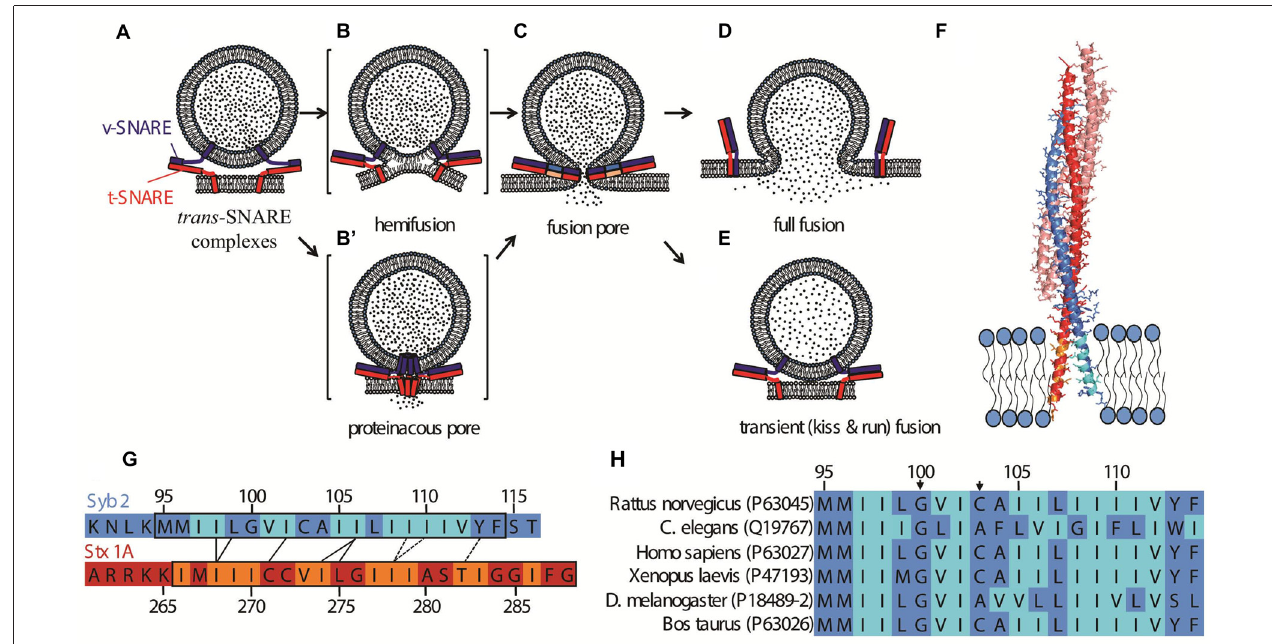
FIGURE 1 | Possible fusion pathways for soluble N-ethyl maleimide sensitive factor attachment protein receptors (SNARE)-mediated fusion, and the structure of the post-fusion cis SNARE complex (Stein et al., 2009). (A) A synaptic vesicle is docked at the plasma membrane by trans -SNARE complexes. The exocytotic/neuronal v-SNARE Syb2 (blue) and the t-SNARE (Stx1 and SNAP25, depicted together in red) are anchored to the synaptic vesicle and the plasma membrane, respectively via their transmembrane domains (TMDs). Further zippering, coupled with the action of the calcium sensor Synaptotagmin-1 (not shown) and possibly other factors leads to the opening of a fusion pore (C) . Possible intermediate structures on the pathway to opening of the fusion pore include a hemifusion state (B) wherein the proximal leaflets, but not the distal ones, are fused. An alternative intermediate is a channel-like structure formed by oligomerization of the TMDs of soluble N-ethyl maleimide sensitive factor attachment protein receptors (SNAREs) in both membranes (B (cid:48) ) . Hetero-oligomerization of SNAREs with other proteins may also contribute to the channel structure. Expansion of the proteinaceous pore would lead to invasion of the pore’s walls by lipids. In (C) , the SNAREs are shown fully zippered at the waist of the pore, but the actual structure is unknown. The fusion pore can fluctuate in size, and flicker open and shut multiple times before expanding further, leading to full fusion (D) , or resealing, concluding a transient or kiss-and-run fusion event (E). (F) Structure of the cis -SNARE complex (adapted from Stein et al., 2009), PDB file 3HD7, rendered in PyMol). The t-SNAREs Syntaxin 1A and SNAP25 are shown in red and salmon, respectively; the v-SNARE Syb2 is shown in blue; TMDs are shown inserted into a membrane. Beta-branched residues are indicated in orange (Stx1) or cyan (Syb2). Note that the ultimate residue in Syb 2 and the last two C-terminal residues in Stx1 were not resolved in the structure and are absent from the image. The plasma membrane thickness is slightly larger than the TMD lengths (Sharpe et al., 2010). (G) Alignment of TMD sequences of Syb2 and Stx1 according to the crytal structure shown in (F) . Contacts between residues observed in the crystal structure are indicated as black lines. The dashed lines indicate residues that face one another, but are further apart, as the two helices veer apart toward the very C-termini. Beta-branched residues are indicated in orange (Stx1) or cyan (Syb2), as in (F) modified from Stein et al. (2009). (H) Alignment of TMDs of Syb2 from several species. Uniprot identifiers (http://www.uniprot.org) are indicated in parentheses. The arrows mark the Gly in position 100 (using the rat sequence as reference) and the tiny residue in position 103. See Hastoy et al. (2017) for a more comprehensive